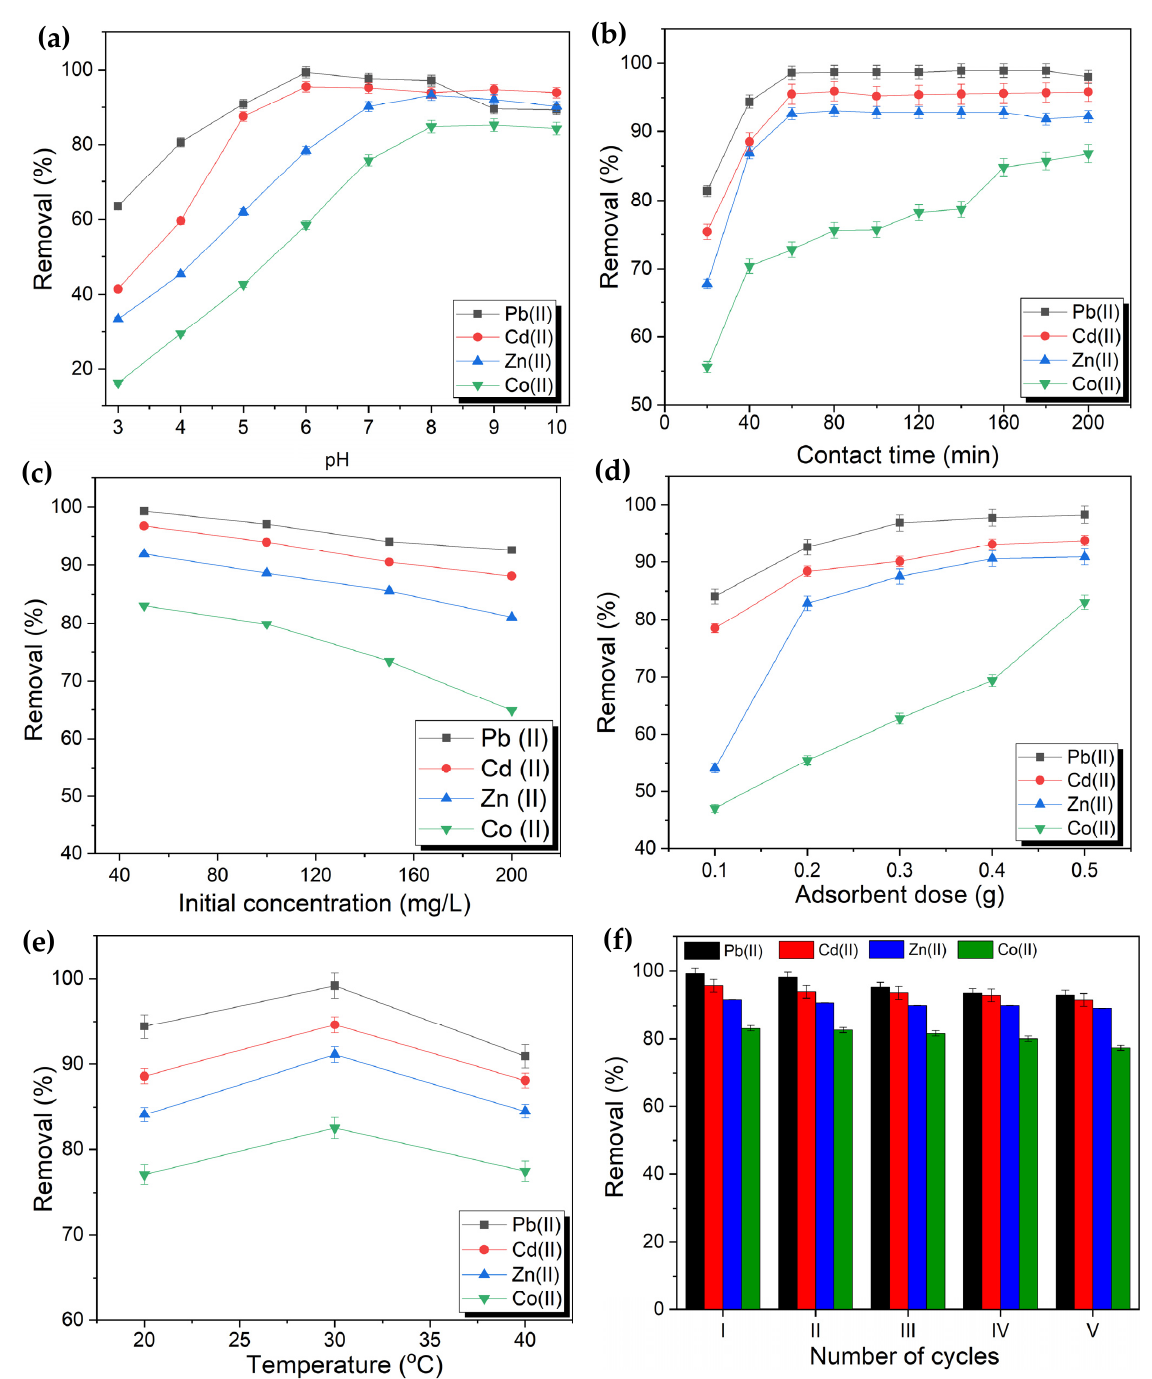
Figure 7. Effects of different factors on the removal efficiency of Pb(II), Cd(II), Zn(II), and Co(II) onto PVA-CS/CE composite hydrogel beads: ( a ) pH (C o [Metals] = 50 mg/L, V = 50 mL, bead dose = 0.5 g, pH = 3–10, t = 200 min, T = 30 °C), ( b ) Contact time (C o [Metals] = 50 mg/L, V = 50 mL, pH = 6 (Pb and Cd) and pH = 8 (Zn and Co), bead dose = 0.5 g, T = 30 °C), ( c ) Initial concentration of metals (V = 50 mL, pH = 6 (Pb and Cd) and pH = 8 (Zn and Co), bead dose = 0.5 g, t = 200 min, T = 30 ◦ C), ( d ) Adsorbent dose (C o [Metals] = 50 mg/L, V = 50 mL, pH = 6 (Pb and Cd) and pH = 8 (Zn and Co), t = 200 min, T = 30 ◦ C), ( e ) Temperature (C o [Metals] = 50 mg/L, V = 50 mL, pH = 6 (Pb and Cd) and pH = 8 (Zn and Co), bead dose = 0.5 g, t = 300 min.), and ( f ) Reusability (C o [Metals] = 50 mg/L, V = 50 mL, pH = 6 (Pb and Cd) and pH = 8 (Zn and Co), bead dose = 0.5 g, t = 200 min, T = 30 ◦